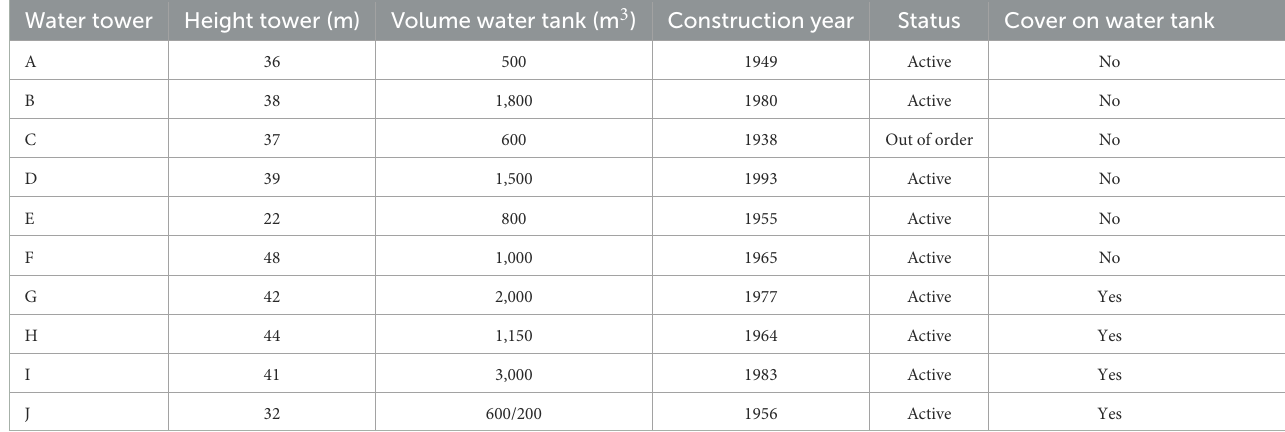
TABLE 1 Characteristics of the monitored water towers. Water